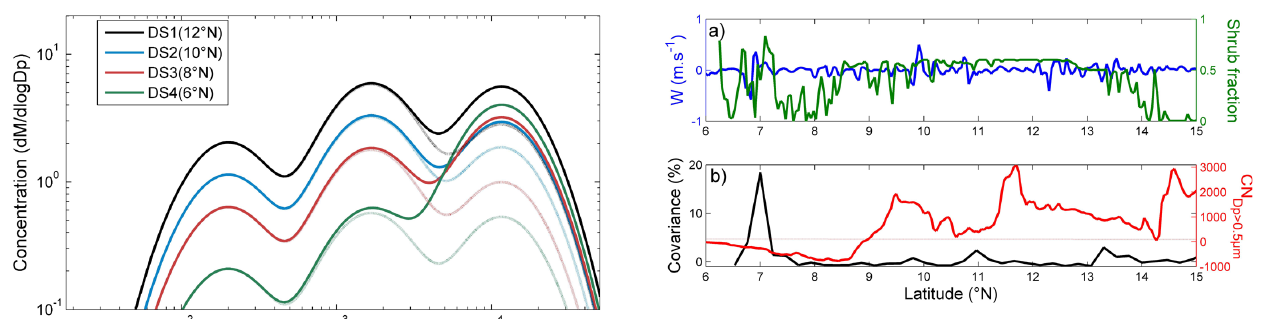
Fig. 13. (a) Difference of vertical wind speed (blue line) between the initial simulation (ECOCLIMAP I, VAR) and the simulation in- cluding surface cover modifications (C30) and Shrub fraction cover of ECOCLIMAP-I (green line). (b) Covariance (black line), in per- cent, between both tendencies (shown in a ) and CNDp > 0.5µm (at 1000m) concentration as a function of latitude at 12:00UTC on 13